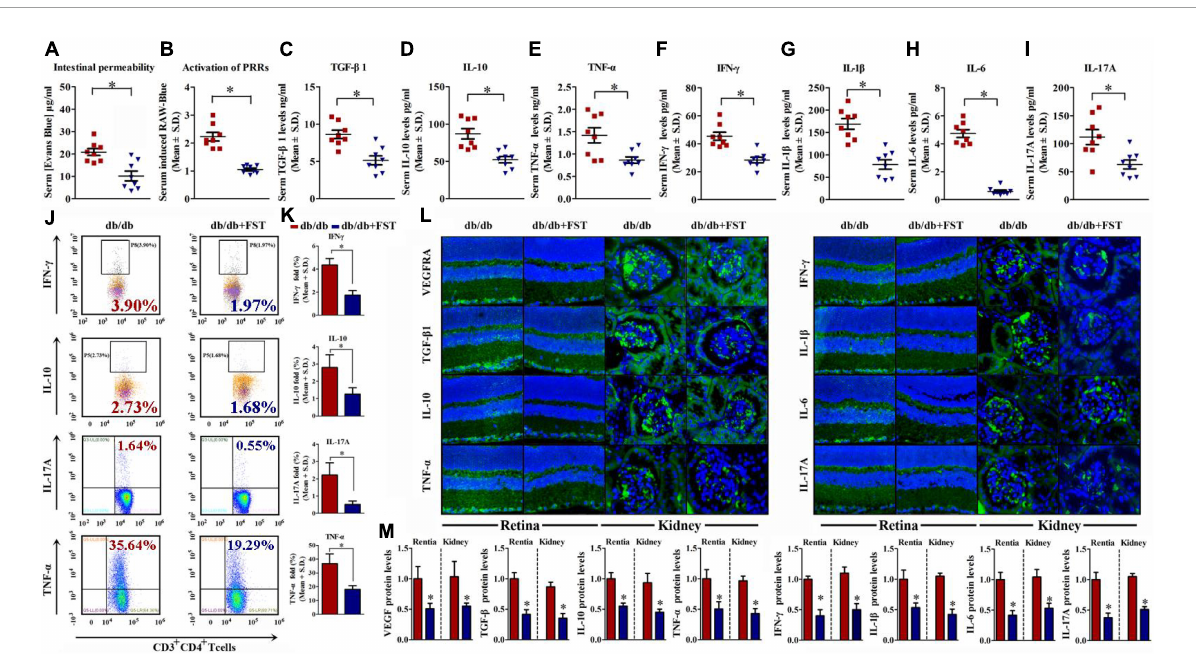
FIGURE6 Microbiotal transfers ameliorated gut permeability, metabolic endotoxemia, and inflammaging condition in obesity mice. (A,B) Concentration of gut-absorbed Evans Blue (A) in serum 24 h after oral administration and activation of PRRs (B) of db/db mice with or without microbiotal transfers. n = 8 in per group. ∗ P < 0.05. (C–I) Serum cytokine profiles of db/db mice with or without microbiotal transfers determined by ELISA assay of TGF- β 1 (C) , IL-10 (D) , TNF- α (E) , IFN- γ (F) , IL-1 β (G) , IL-6 (H) , and IL-17A (I) . n = 8 in per group. ∗ P < 0.05. (J,K) IFN- γ , IL-10, IL-17A, and TNF- α levels were assayed by flow cytometry. n = 8 in per group. ∗ P < 0.05. (L,M) Representative immunofluorescence images of retina and kidney tissues stained with VEGFA, TGF- β 1, IL-10, TNF- α , IFN- γ , IL-1 β , IL-6, and IL-17A antibodies in db/db mice with or without microbiotal transfers (L) . The relative quantitative analyses were presented in (M) . Bar = 50 µ m. Data are expressed as the means ± S.D., n = 8 in per group. ∗ P <